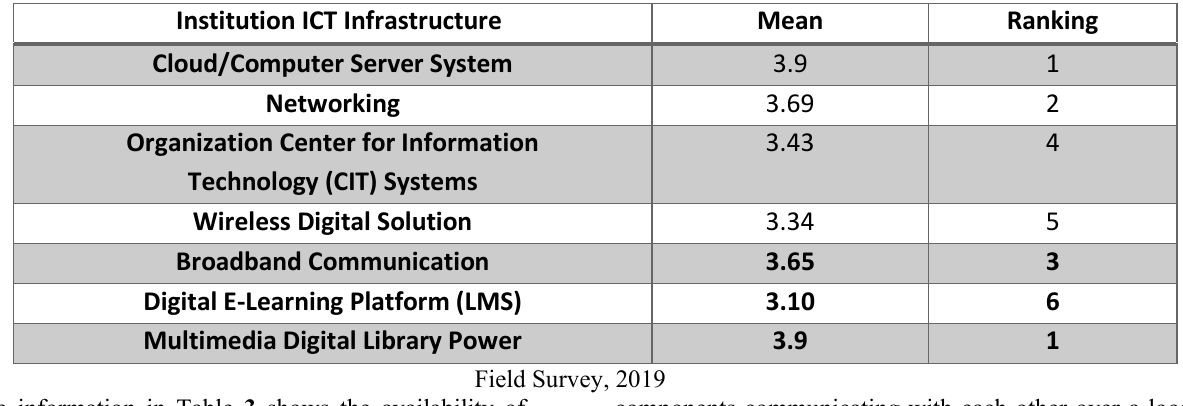
Table 3. Institutional ICT Capacity Development & Infrastructural Marginal